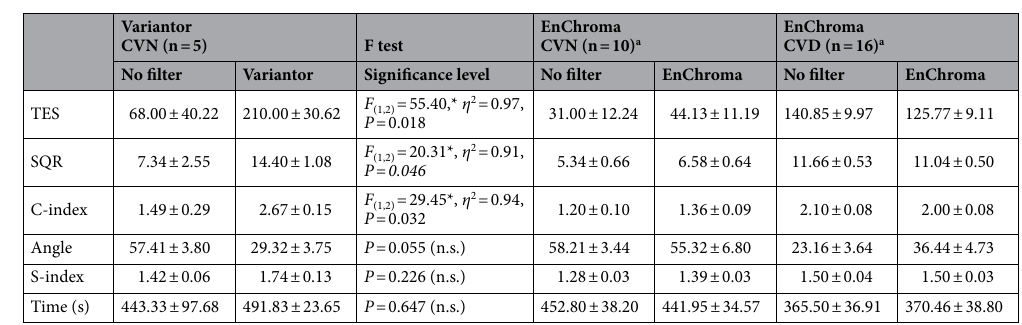
Table 1. FM100 Indicator scores, with and without filters. Significant main effects and Tukey post-hoc comparisons on filter vs no-filter effects for FM100 indicators. Exact P-values and n.s. (not significant) indicate statistical significance levels of main ANOVA. a No significant differences found for EnChroma filters (vs no-filters) using Tukey post-hoc comparisons for CVN or CVD